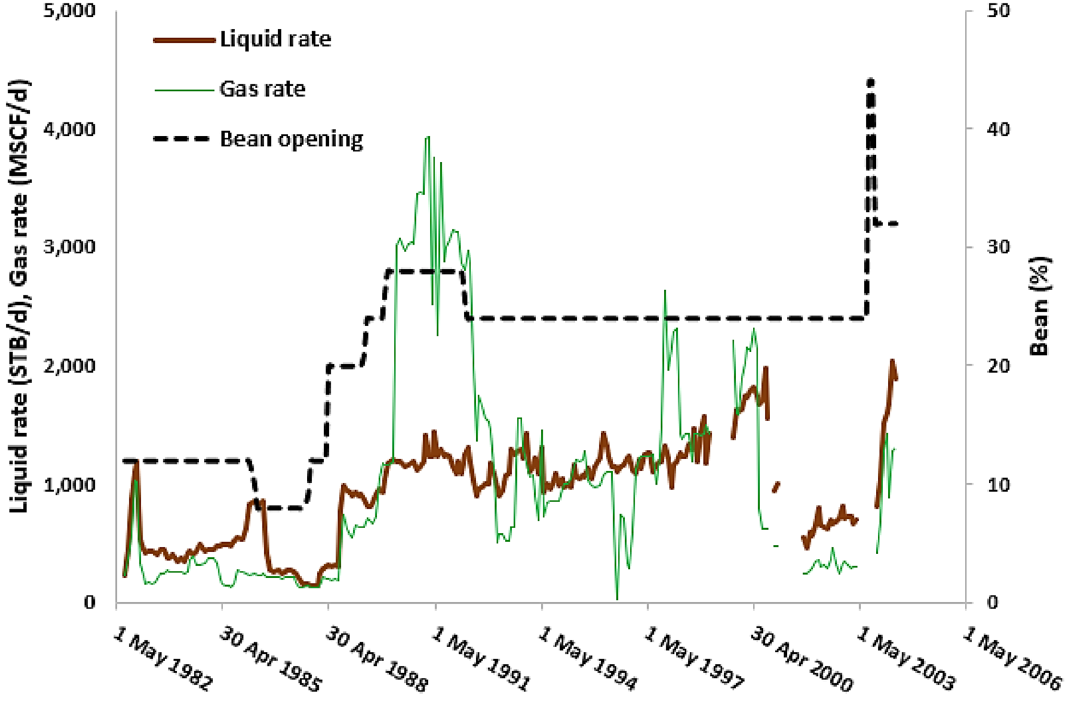
Fig. 15 Liquid and gas rates production history of well